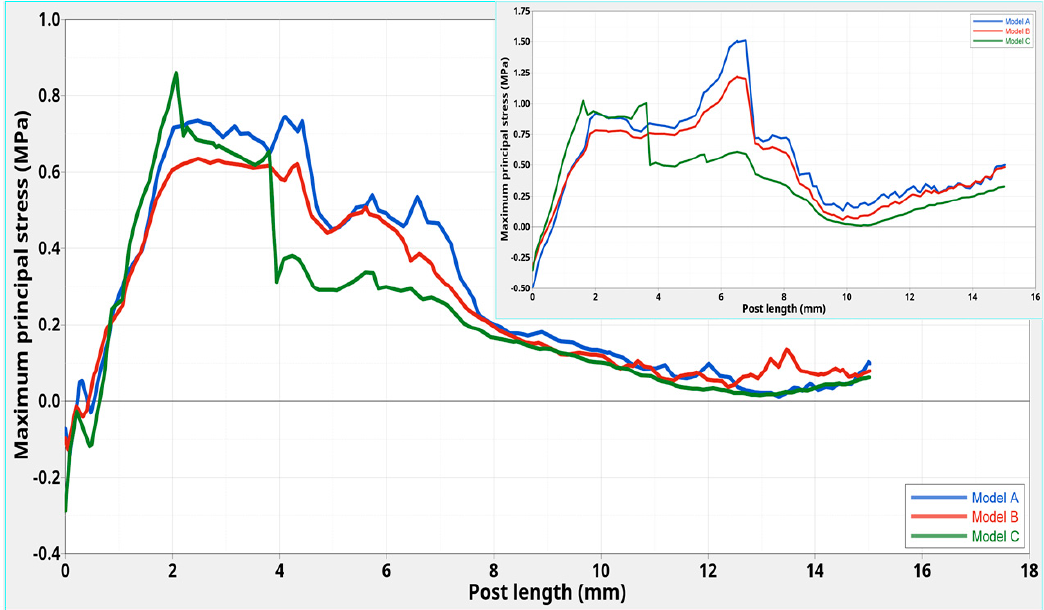
Figure 4. Models A , B, and C : maximum principal stress distributions along the center of the post from the coronal to the apical part. The inset is for corresponding models without a ferrule [12]. were apparent especially for Model A in comparison to B and C (Figures 5 and 6). Different maximum principal stress distributions were evident along the three C-G/PEI posts.